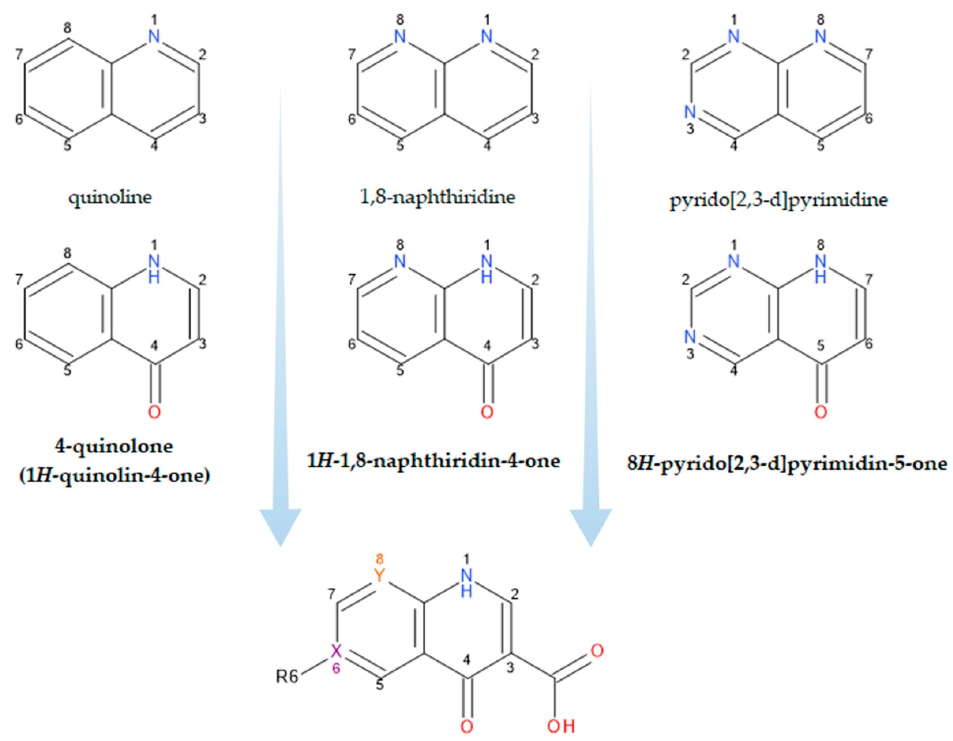
Figure 1. Structural precursors and general structure of QNs (FQNs if R6 = F); X, Y = C or N.